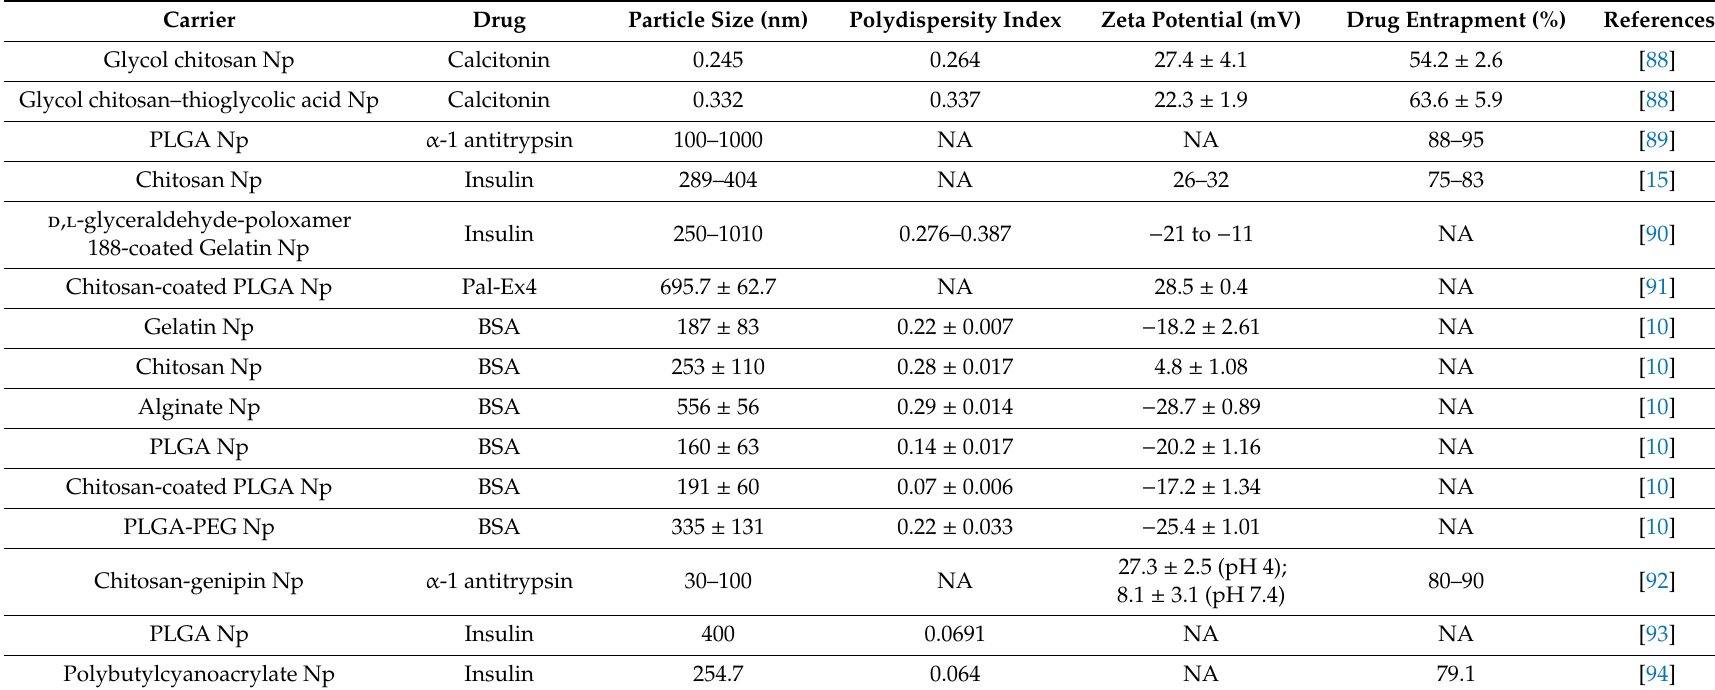
Table 3. Physicochemical properties of inhalable protein-loaded polymeric